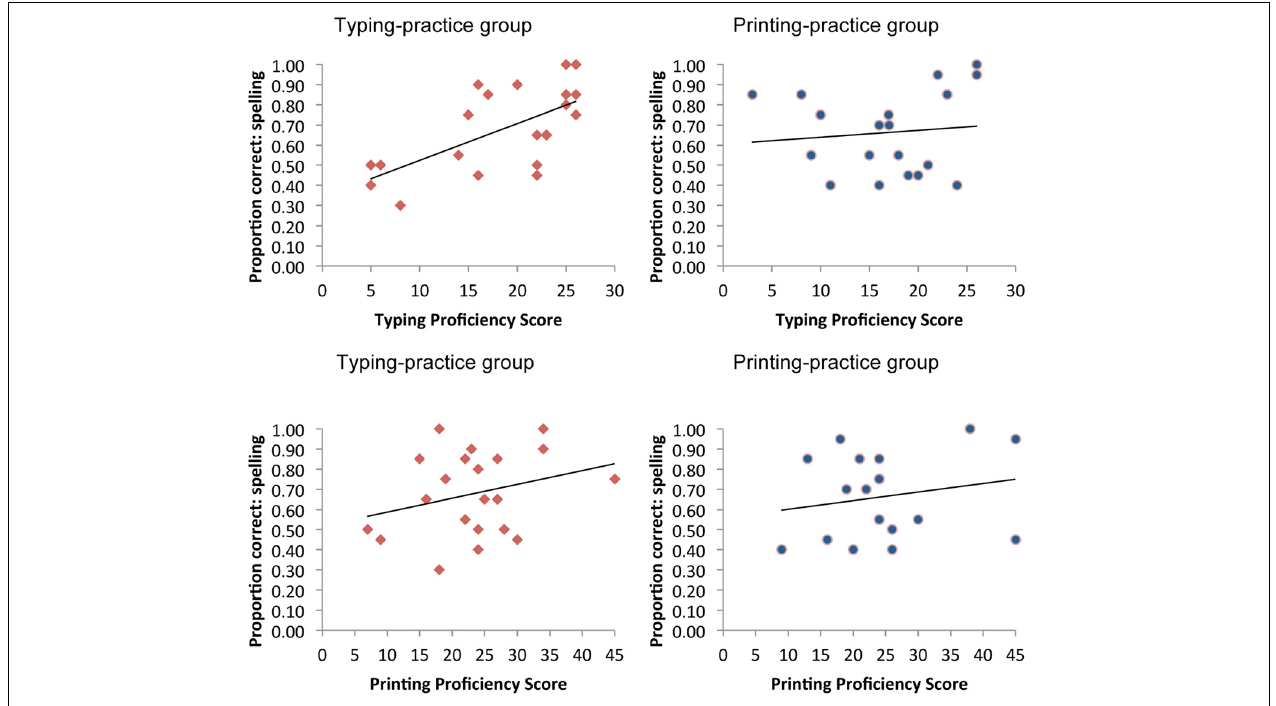
FIGURE 1 | Scatterplots of the relations between pre-tested areas and performance on the spelling post-tests, as a function of practice group. The upper panels depict the nature of the